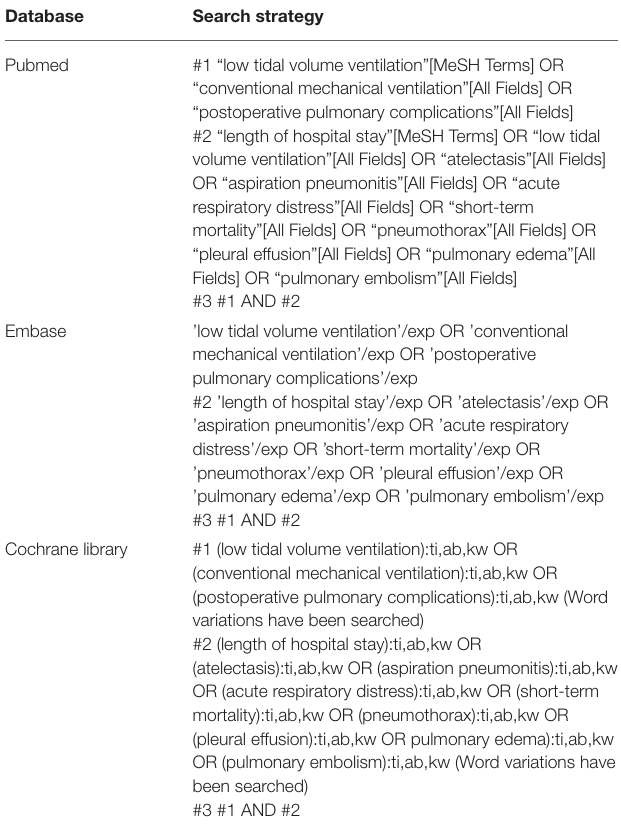
TABLE 1 | Search strategy for each